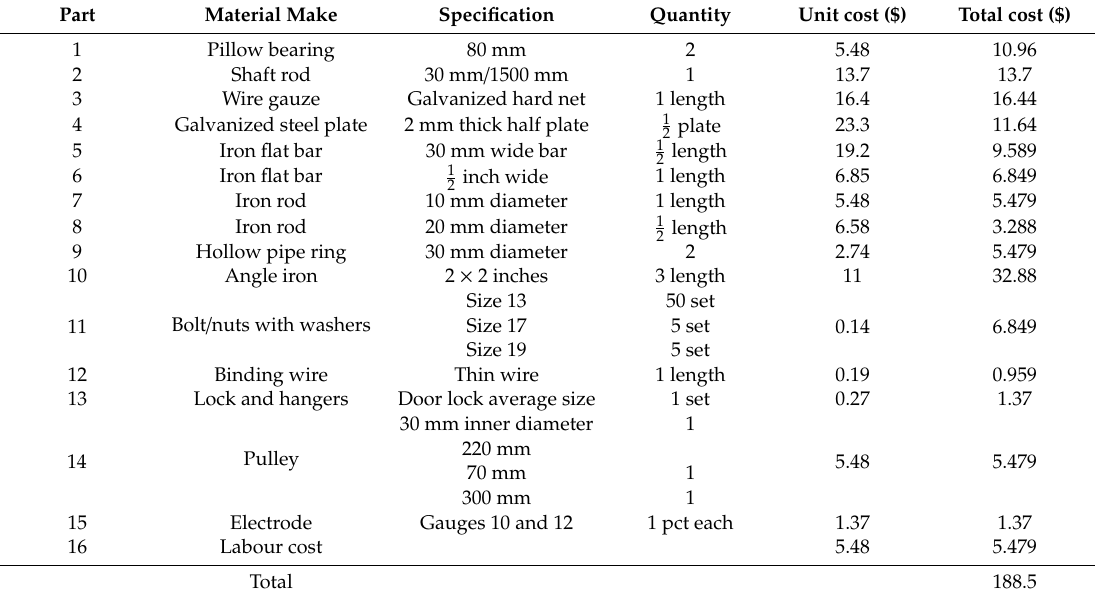
Table 4. Bill for engineering measurement and evaluation.